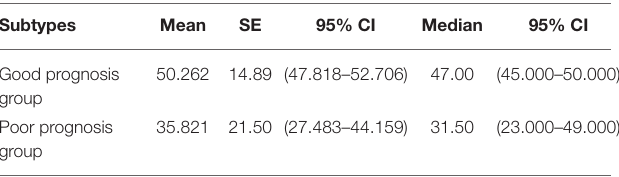
SE, standard error; CI, confidence